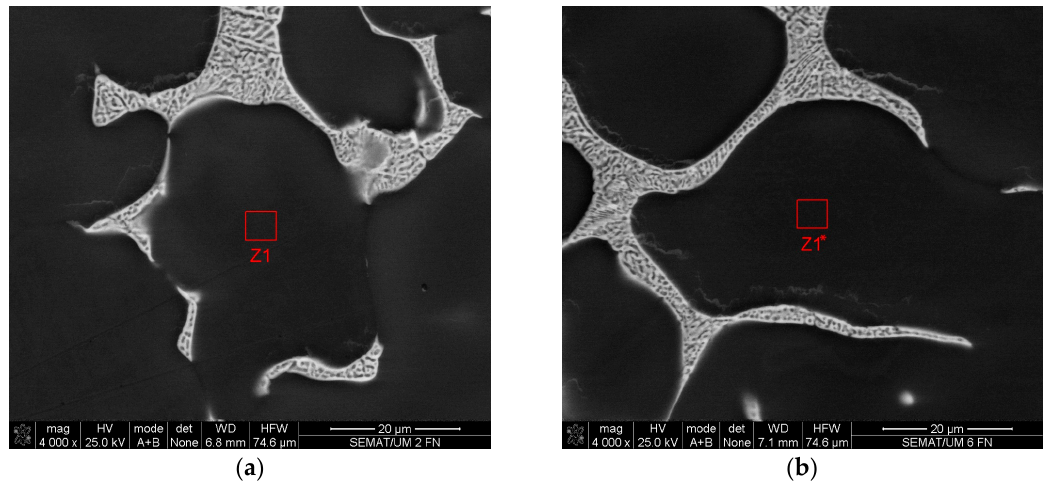
Figure 18. Traces of titanium in α -Al in (a ) batch 45U and ( b ) batch 90U. Table 3. EDS quantification of the points in Figure